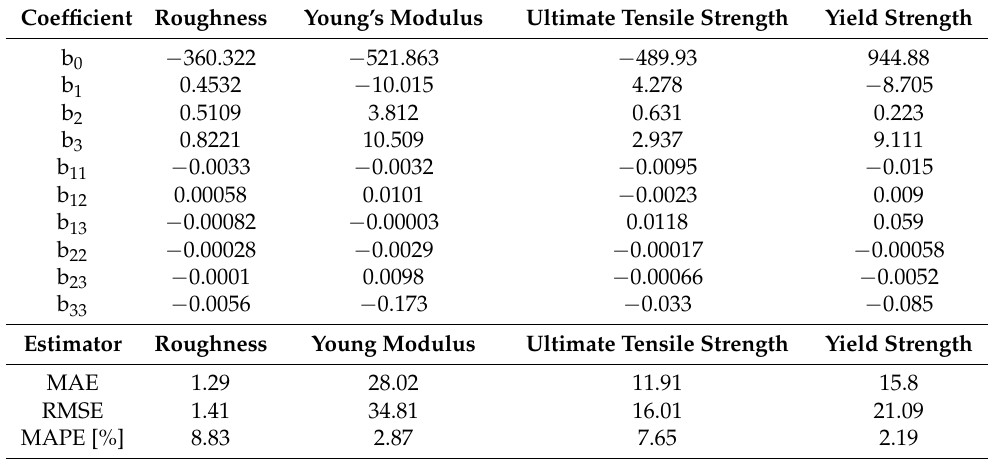
Table 4. Polynomial regression coefficients and performance for each of the developed models considering the training